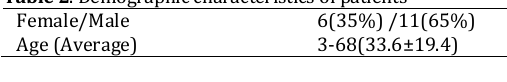
Table 3. The location of the lesion Cervicothoracic spine 6(35%) Middle and lower thoracic spine